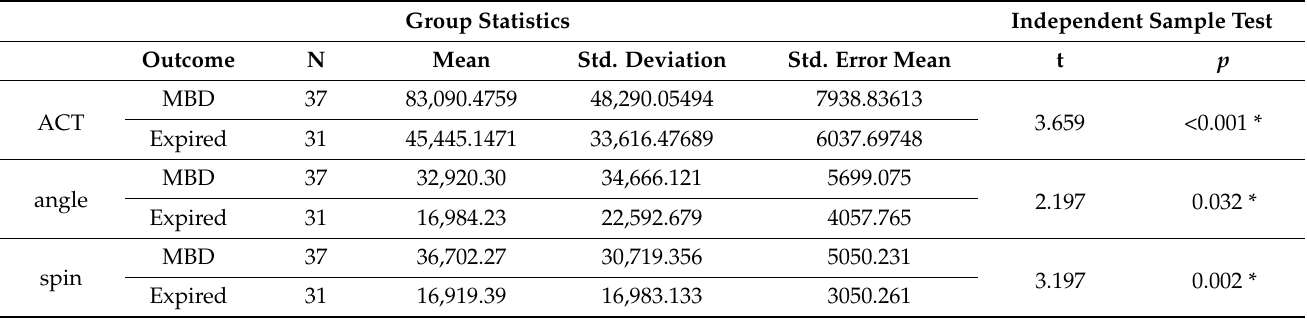
Figure 10. Differential representation between the ACT, angle, and spin at 24 hours in order see the relationship between two variables (MBD and expire). Table 4. Statistical difference in ACT, angle, and spin values for MBD and expired in 48 h data ( p < 0.05 is considered as significant *).